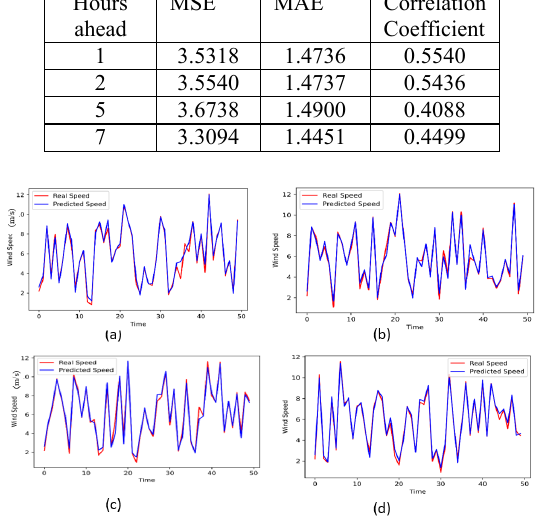
Figure 14. Wind speed prediction in Case 2, (a) 1 hour ahead (b) 2 hours ahead, (c) 5 hours ahead, (d) 7 hours ahead.